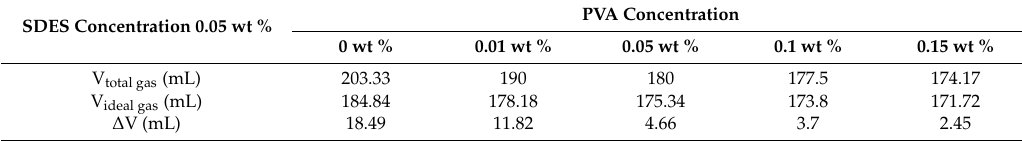
Table 2. The values of ∆ V, V total gas , and V ideal gas at an SDES concentration of 0.05 wt %.